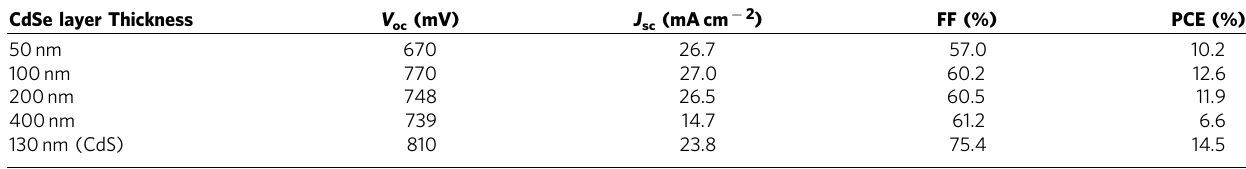
Table 1 | Photovoltaic performance parameters.